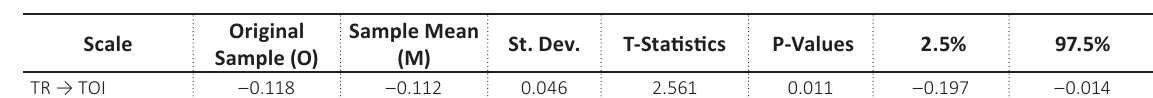
Table 6. Significance testing of indirect effects